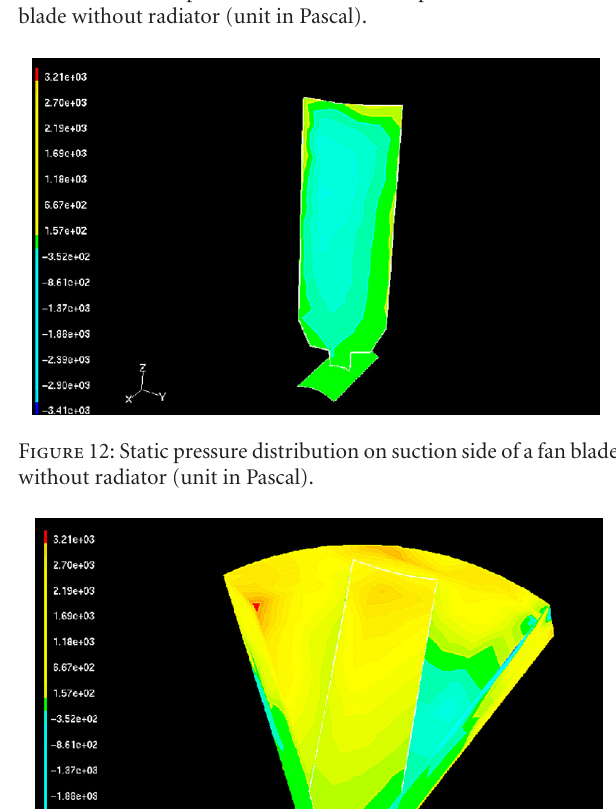
Figure 8: CAD model of the axial fan.